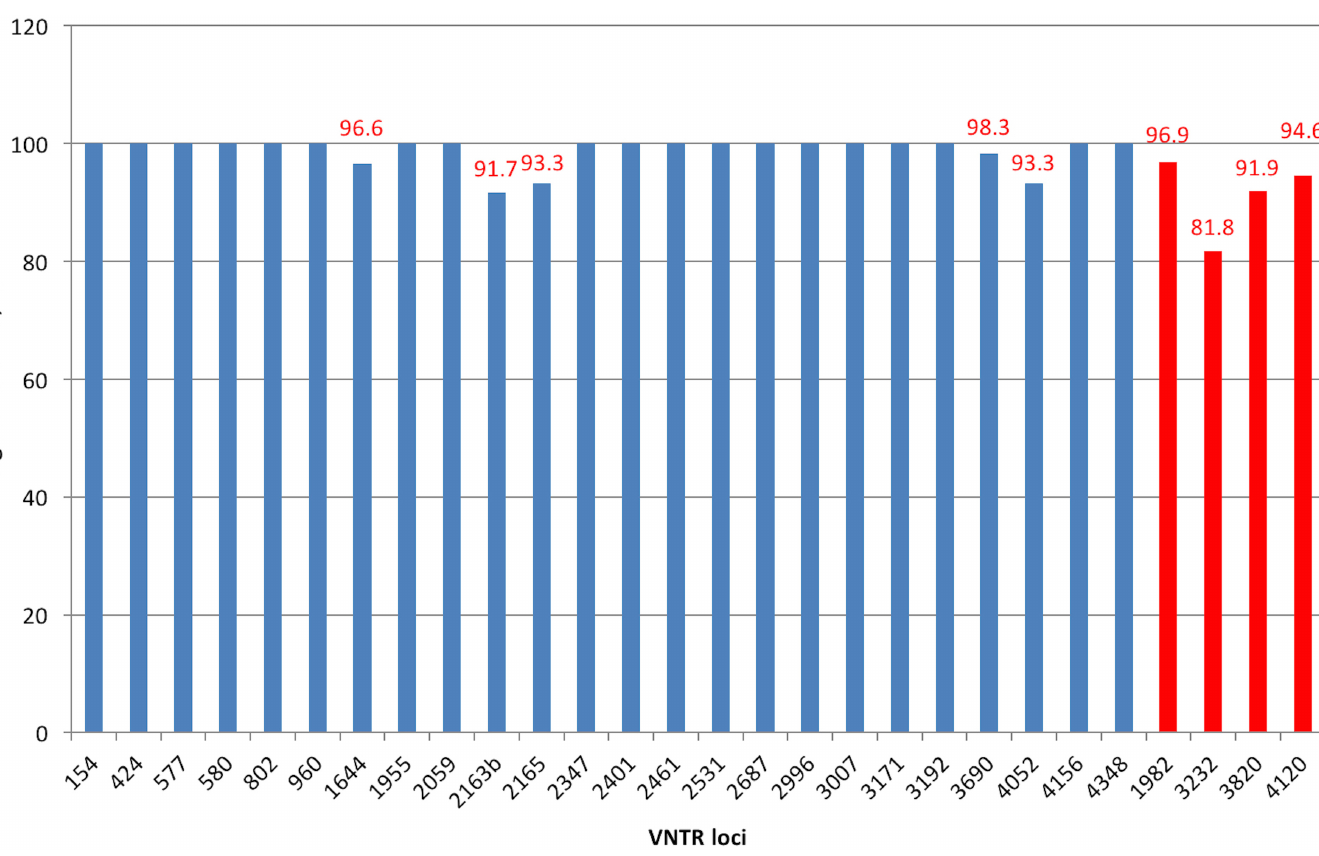
Fig 3. Interlaboratory agreement rates. Hypervariable loci shown in red colour. In cases where results from both laboratories were incorrect, these values were not included in